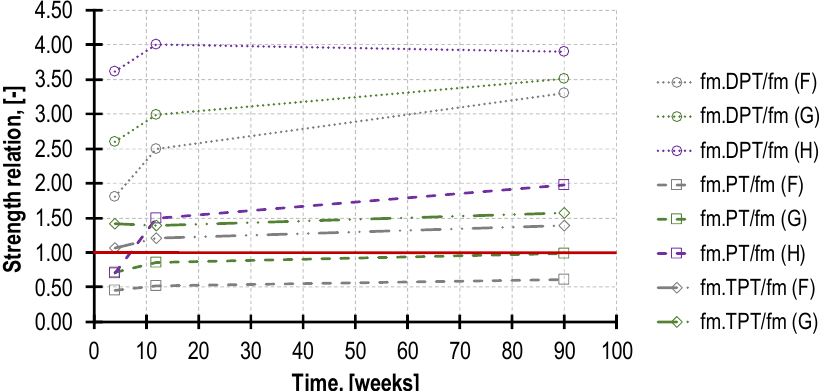
Figure 18. Time changing strengths relation, allowing to convert mortar strength obtained by all MDTs to reference strength f m . The red line separates MDTs that return mortar strength higher than f m (are above) from those which return values lower than f m (are below).